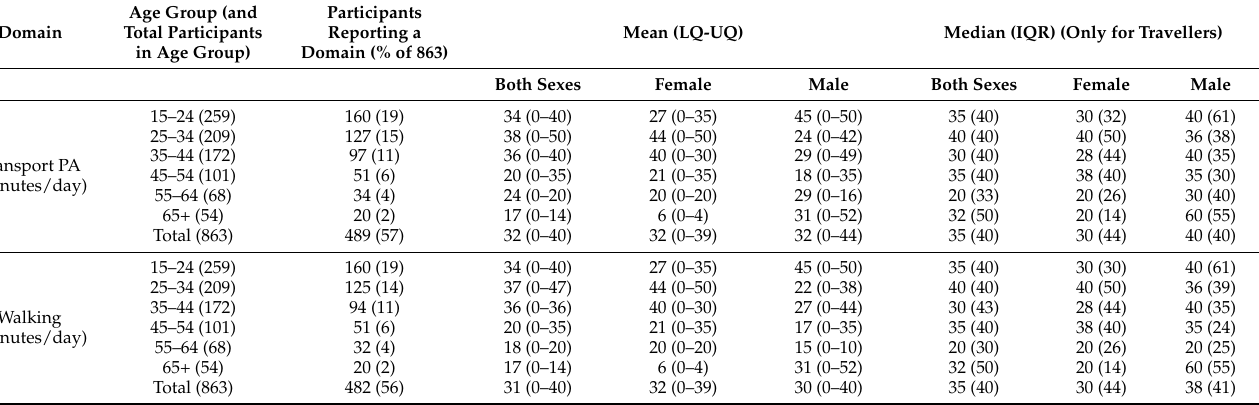
Table 4. Total and mode–specific transport physical activity by age and gender from the travel diary in Accra,